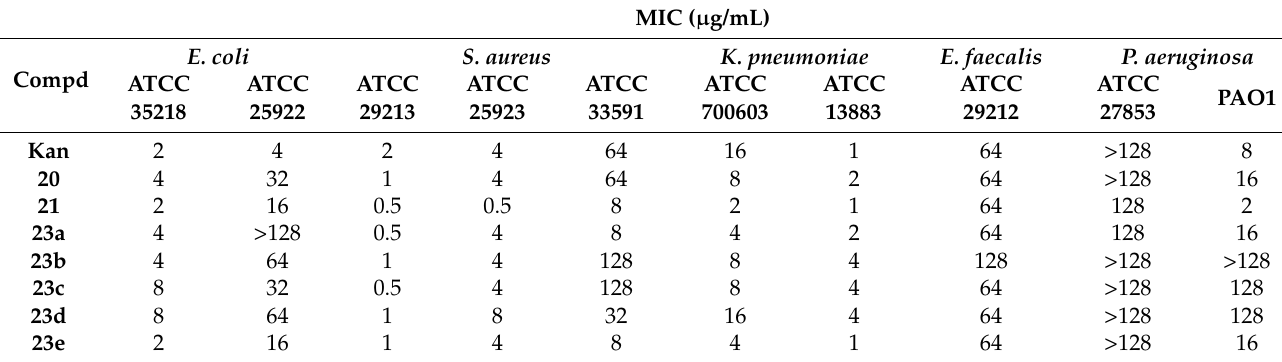
Table 1. The results of antibacterial activities of synthesized